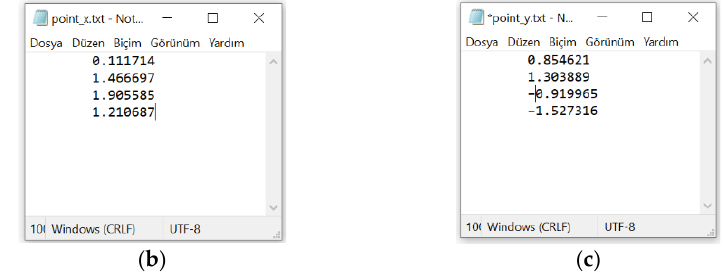
Figure 12. ( a ) Sequential names of operating points; ( b ) coordinates on the x-axis of the working points; ( c ) coordinates on the y-axis of the working points recorded during the physical test.